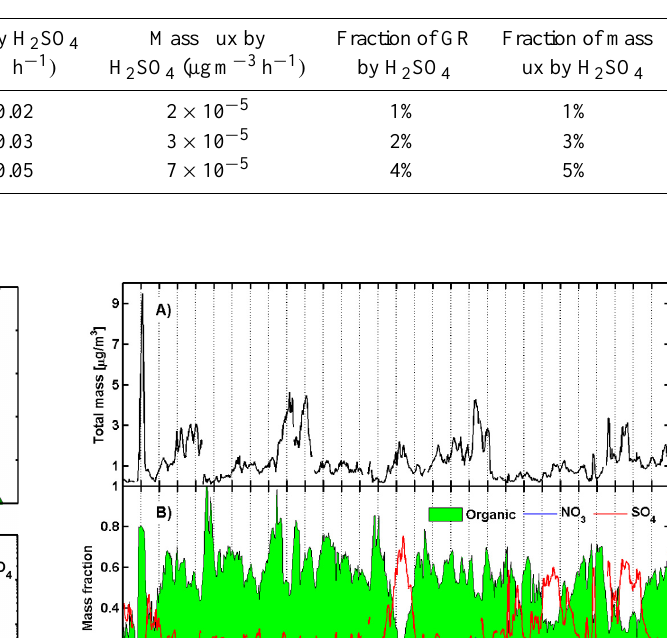
Table 1. The median and quartile growth rates and mass fluxes in Hyyti¨al¨a during years 2003–2007, along with the corresponding growth rates and mass fluxes explained by ambient sulfuric acid concentrations.